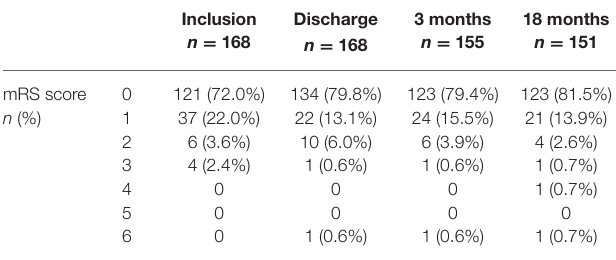
TABLE 6 | Clinical